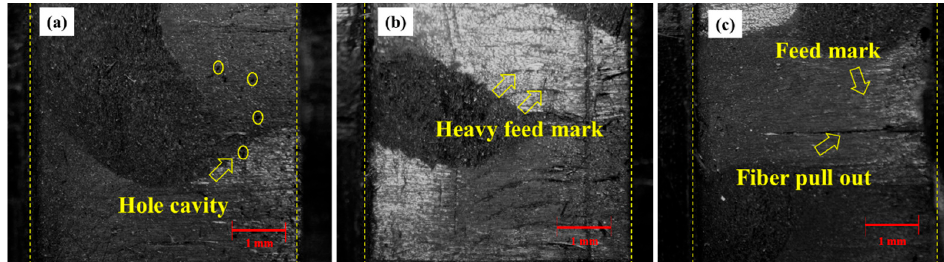
Figure 6. Microscope image of the machined slot at lower cutting speed for ( a ) 1 wt.% GO, ( b ) 2 wt.% GO, and ( c ) 3 wt.% GO.